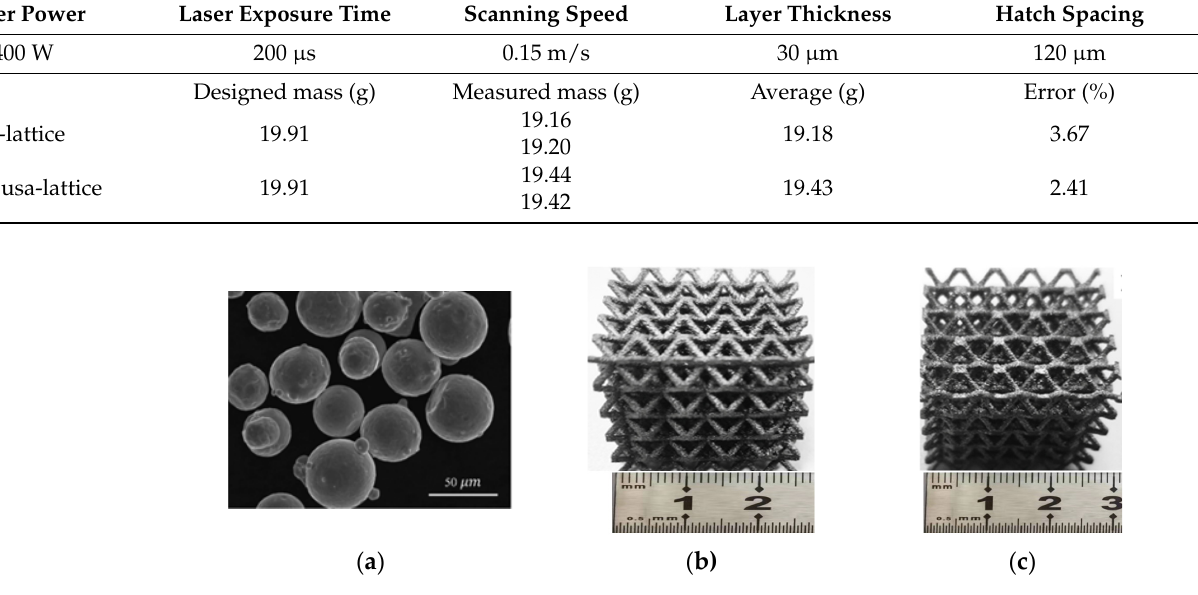
Table 2. Printing process parameters and masses of the lattice samples.